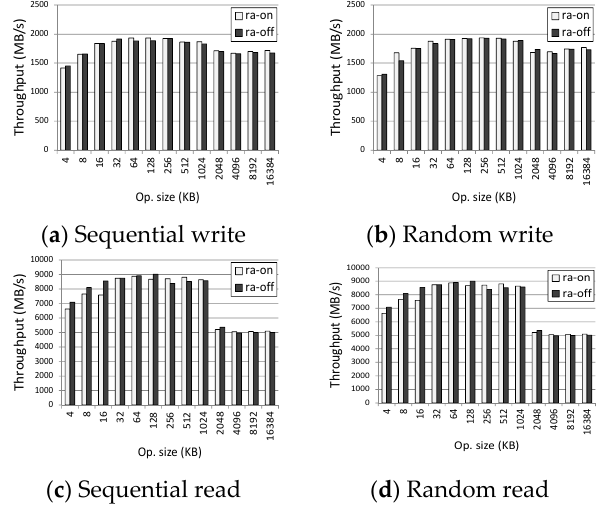
Figure 10. PCMdisk performance when the prefetching option is turned on/off.